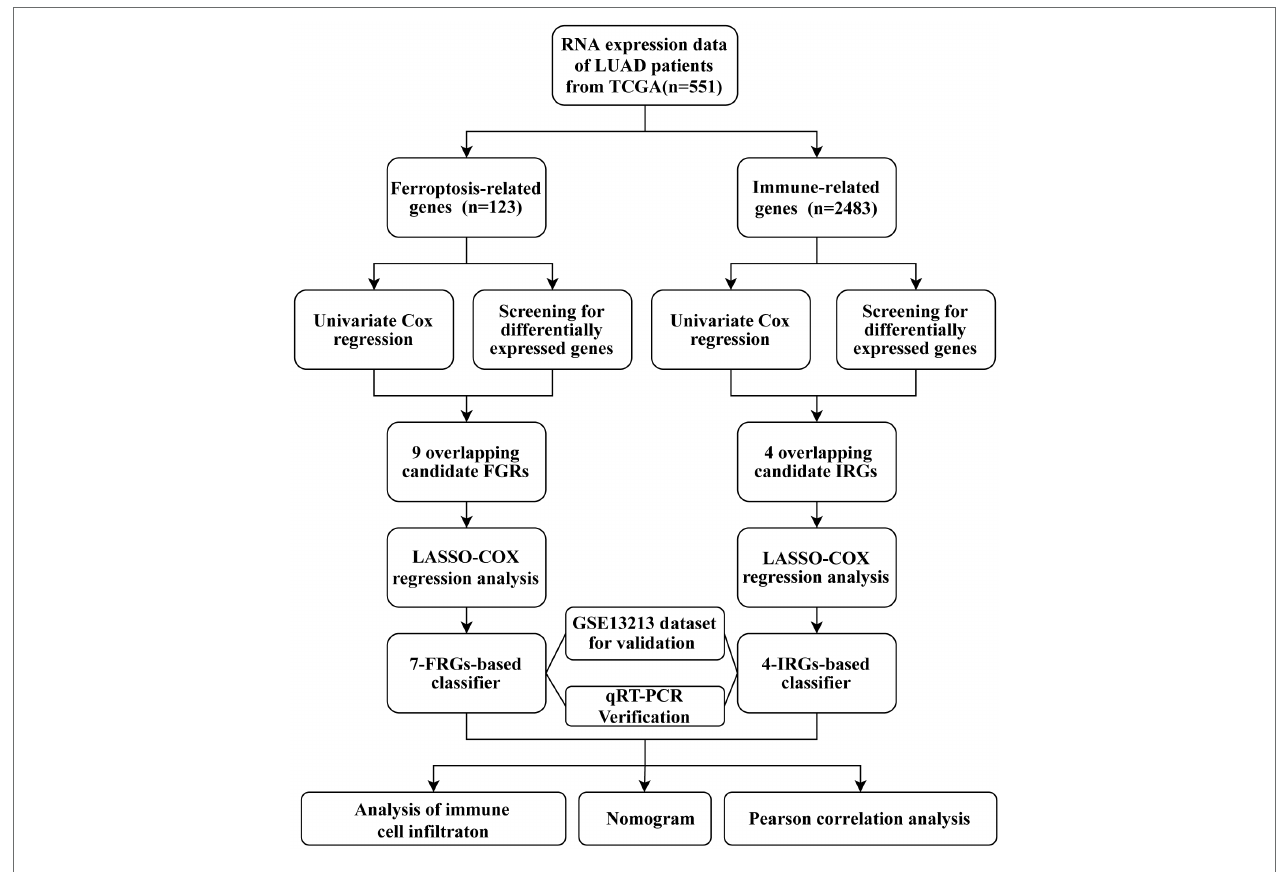
FIGURE 1 | Workflow